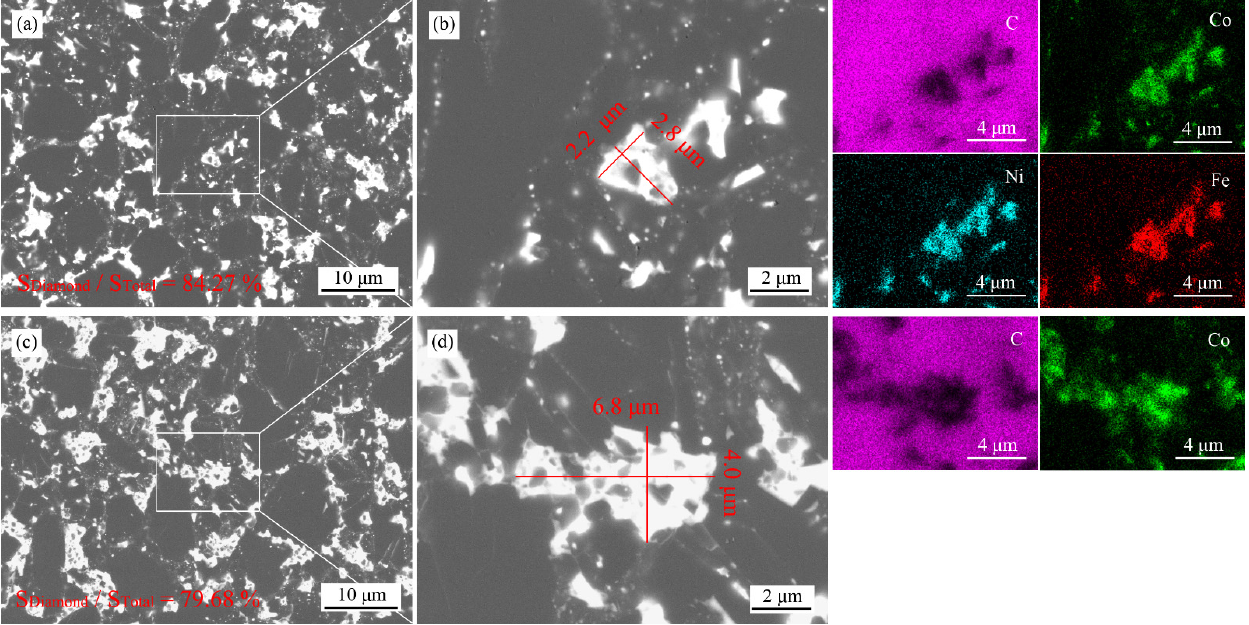
50 Ni 40 Fe 10 -Comp ( a , b ) and Co-Comp ( c , d ).